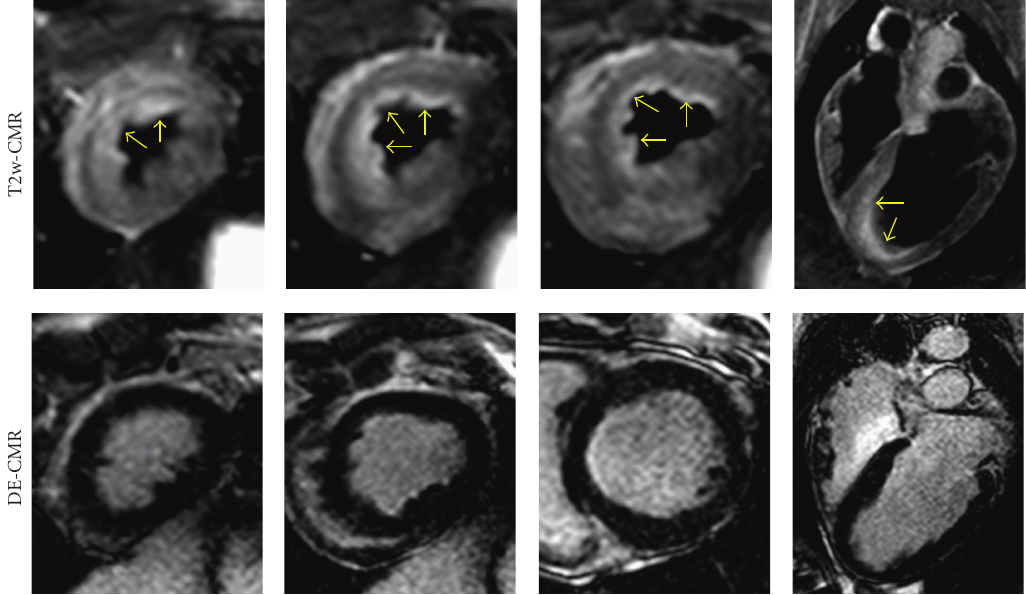
Figure 3: Corresponding short axis and long axis images obtained by CMR. T2w-CMR images showed uptake in the anterior wall (arrows), indicating myocardial edema from ischemia mainly in subendocardium (upper row). However, no specific change was found in delayed enhancement images (lower row). CMR: cardiac magnetic resonance DE: delayed enhancement.